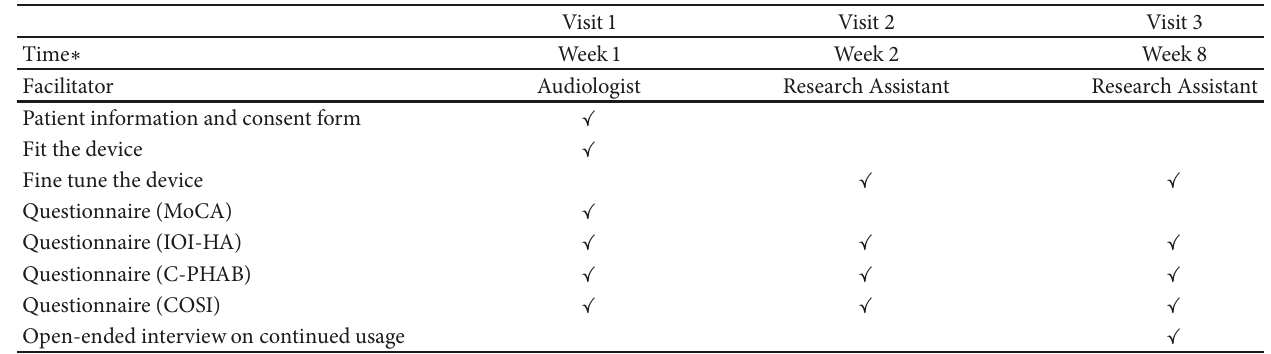
Table 1: Participant visit schedule and